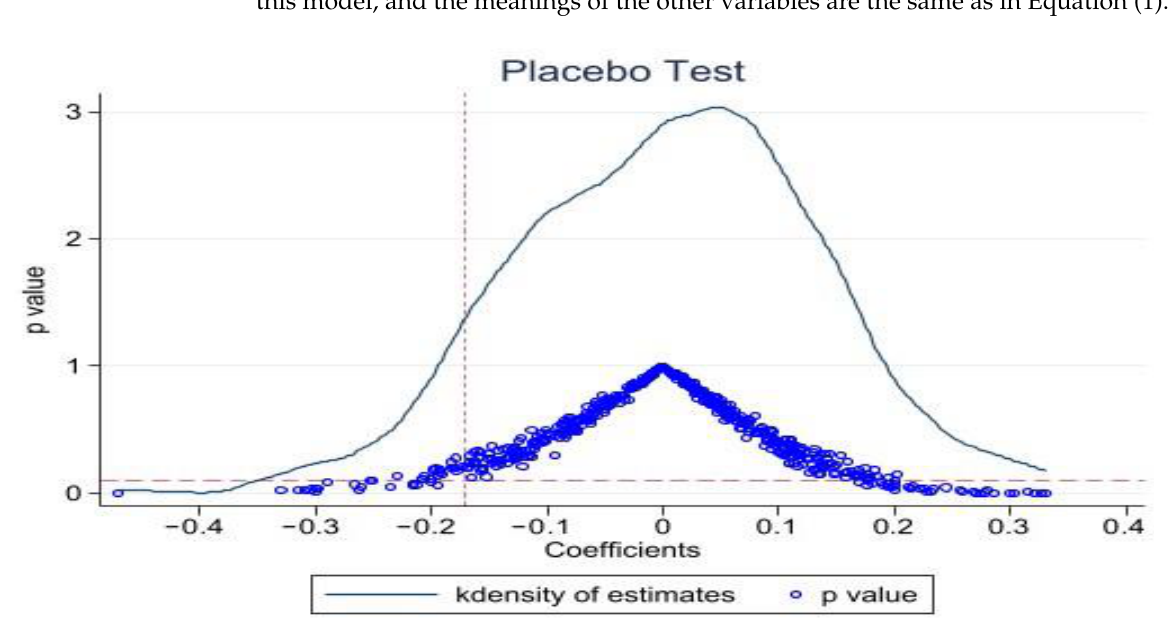
Figure 2. Placebo